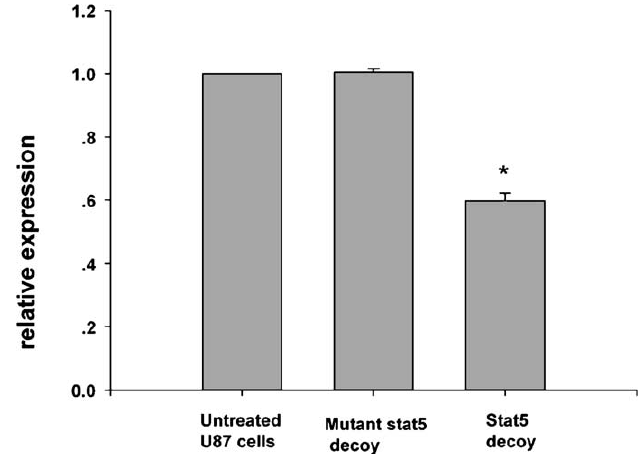
Fig. 4C. The expression of human IL-13Ra2 transcript G in U87 cells can be inhibited with stat5 decoy ODN. Stat5 mutant ODN was used as control. For Fig. 4A–C, the expression of human IL-13Ra2 transcript G was evaluated with real-time RT-PCR. Normalization of the data was done against control GAPDH expression, and indicated as relative expression. Columns and bars represent mean and SD, respectively, and represent values from three independent